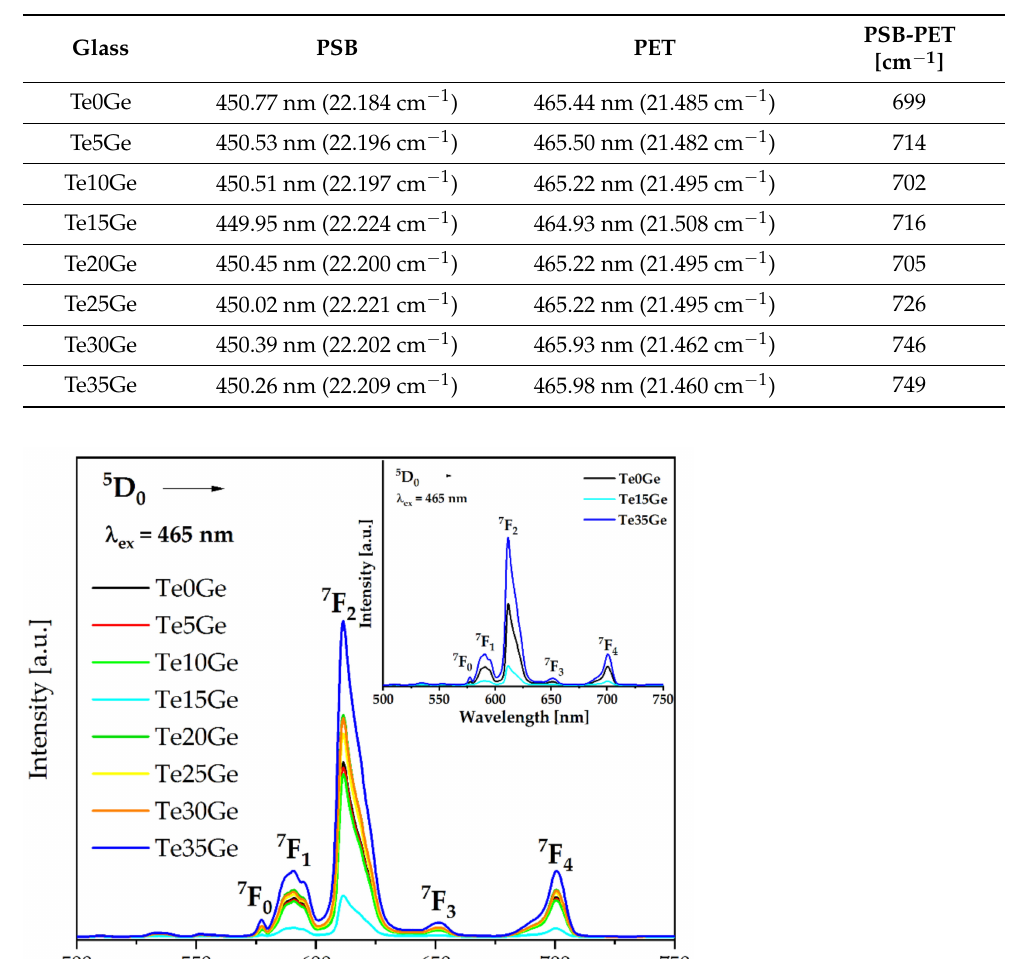
Table 4. Phonon energies determined from the excitation spectra of the studied glasses.